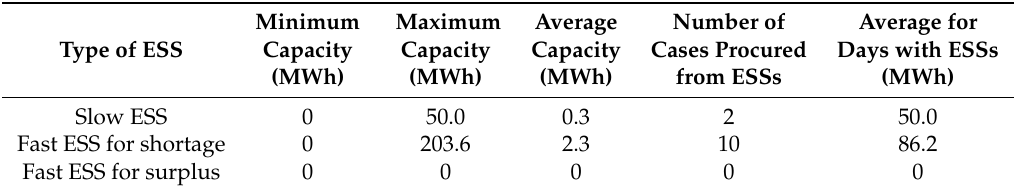
Table 1. Data of ESS